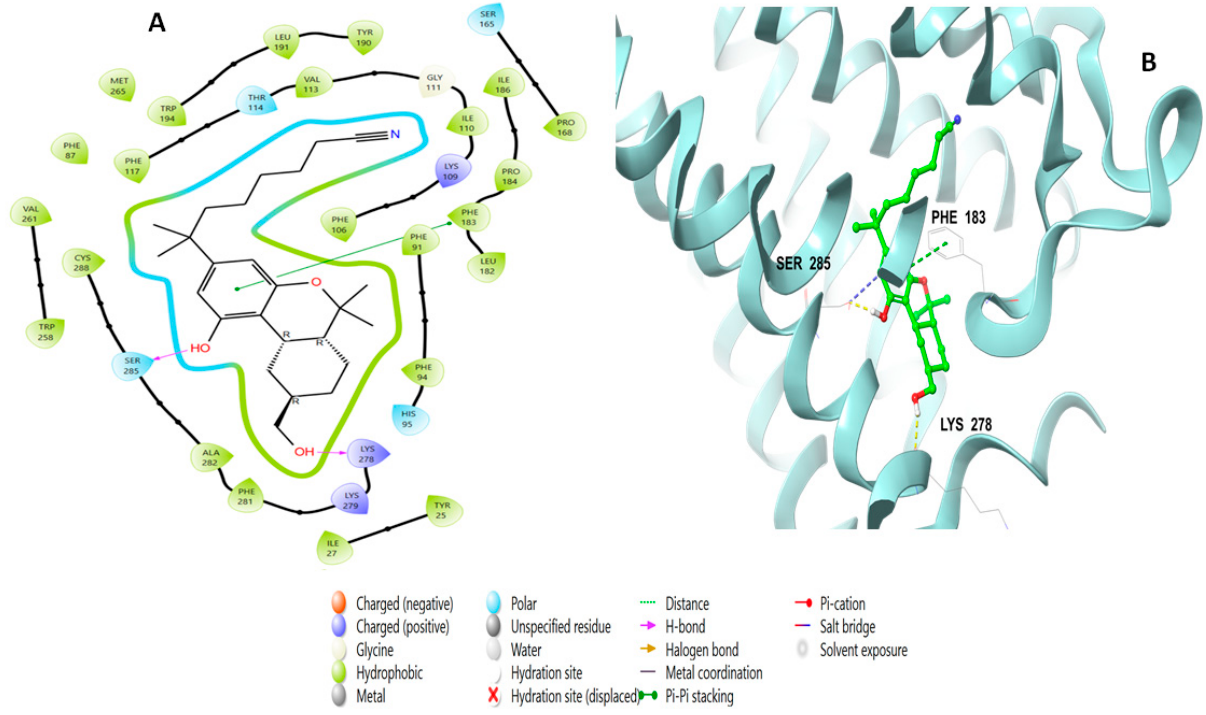
Figure 4. Putative binding mode of native agonist (PDB-ID: E3R ) in the binding site of CB2 receptor (PDB-ID: 6KPF). E3R is displayed as green sticks. H bonds are displayed as yellow dotted lines and ionic bonds as blue dotted lines. ( A ) 2D depict; ( B ) 3D representation of CB2 complexed with E3R